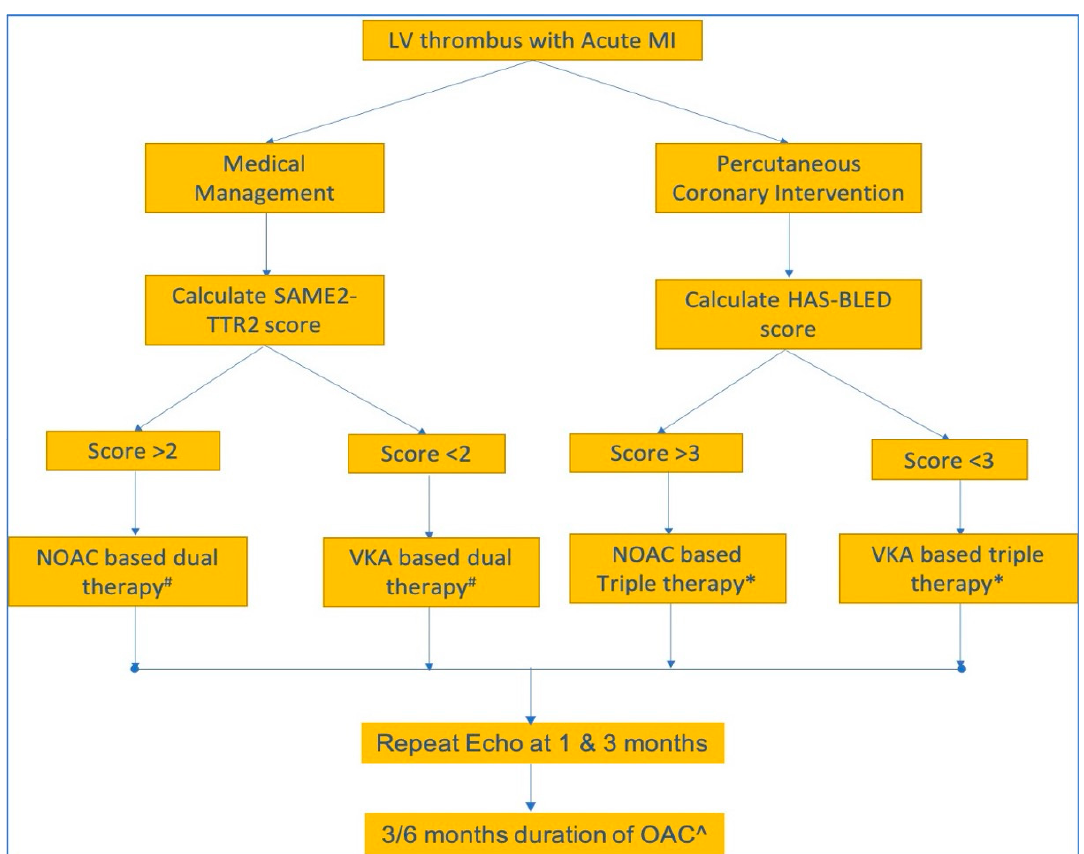
Figure 4. An approach to anticoagulation in LV thrombus complicating acute MI utilizing risk stratification scores. Dual therapy refers to a combination of single antiplatelet agent and oral anticoagulation. Triple therapy refers to a combination of dual antiplatelet therapy and oral anticoagulation. Presence of high ‐ risk features warrants upgradation to VKAs from NOACs or triple therapy from dual. The variables used in HAS ‐ BLED score include hypertension, abnormal renal or liver enzymes, stroke, bleeding events, labile INR, elderly age (>65 yrs), and drugs or ethanol. The SAMeT2TR2 score variables are sex (female), age (< 60 yrs), medical history, treatment strategy (rhythm control), tobacco use, and race (nonwhite race). Notes: #—prasugrel and ticagrelor should be avoided in dual or triple therapy; *—generally continued for 1 month, followed by dual therapy to avoid bleeding, and in the case of embolic events, it can be continued beyond 1 month; ˆ- ACC/AHA and